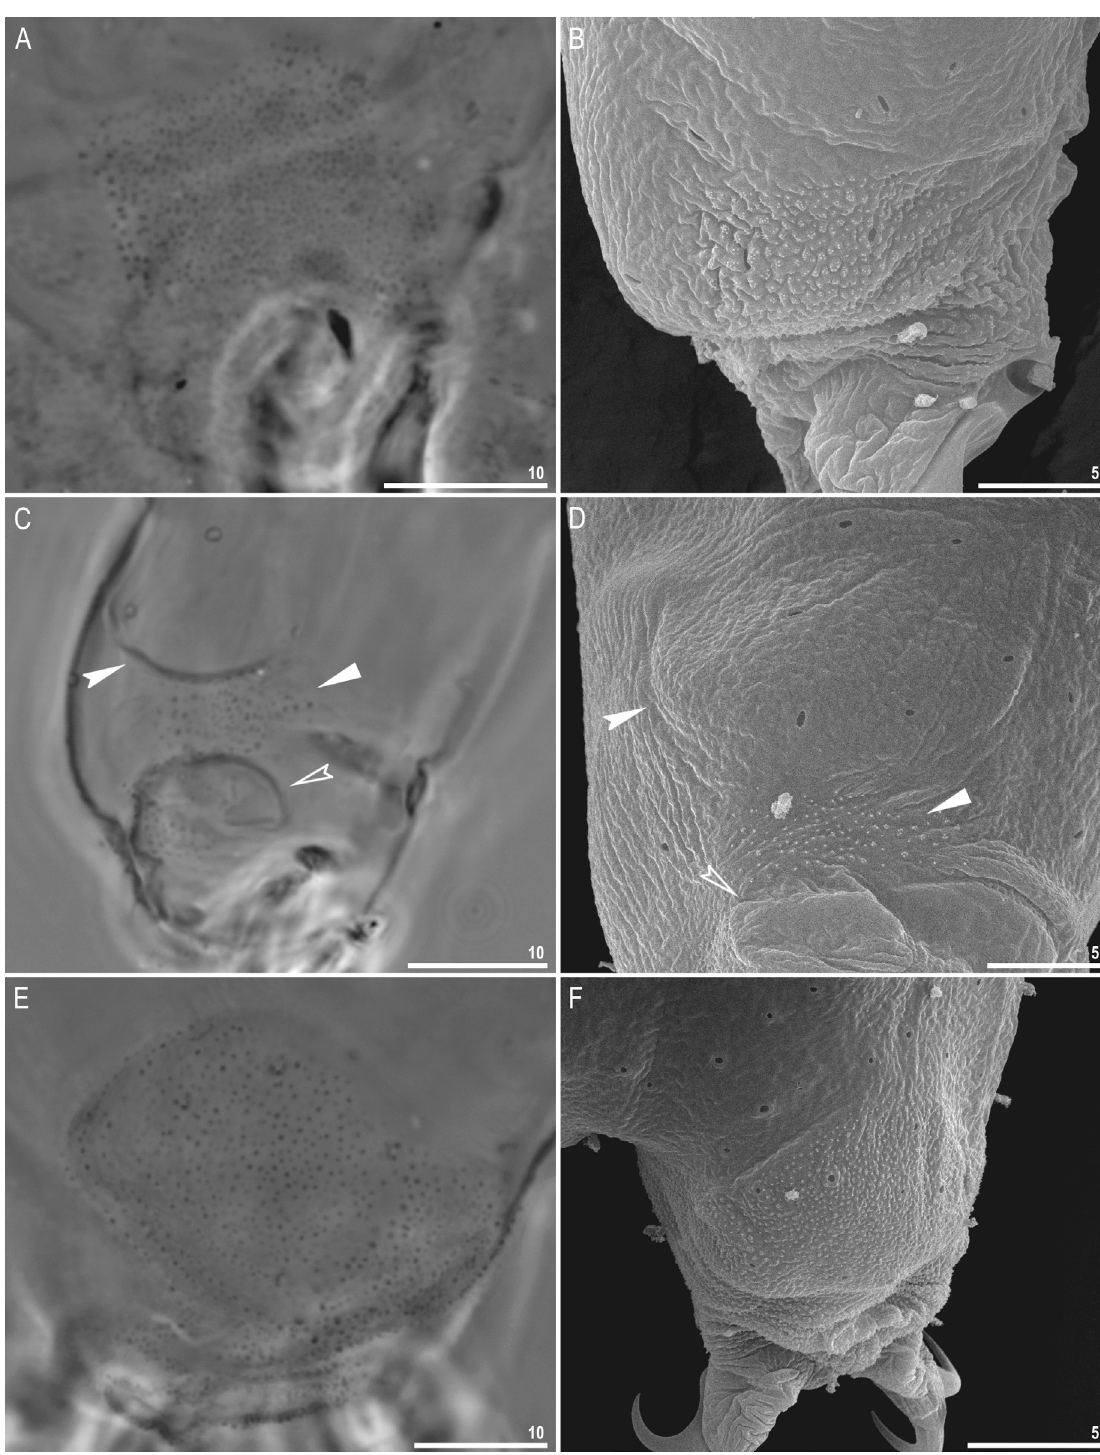
Fig. 9. Macrobiotus kamilae sp. nov., cuticular structures on legs (paratypes, IZiBB). A–B . External granulation on legs III and I seen in PCM (A) and SEM (B), respectively. C–D . A cuticular bulge (pulvinus), granulation and a cuticular fold on the internal surface of leg III seen in PCM (C) and SEM (D). E–F . Granulation on leg IV seen in PCM (E) and SEM (F). Filled indented arrowheads indicate the cuticular bulge, filled flat arrowheads indicate patch of granulation and empty indented arrowheads indicate the cuticular fold under the claws. Scale bars in